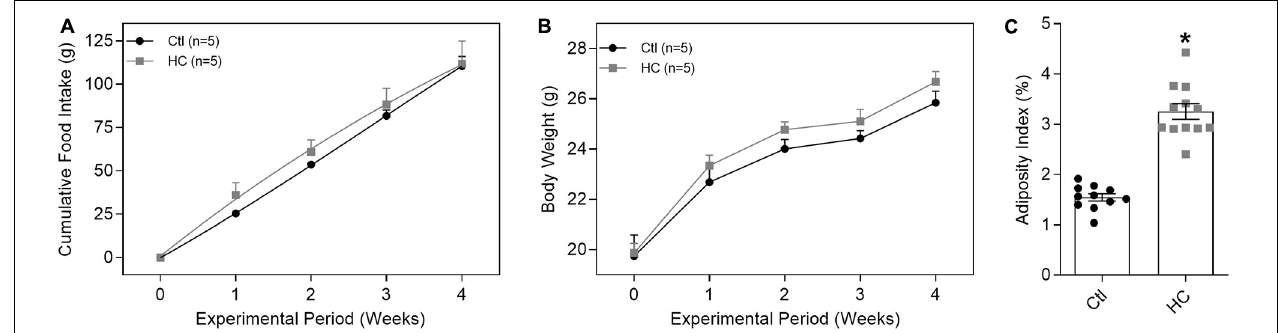
FIGURE 1 | Evaluation of (A) cumulative food intake, (B) body weight, and (C) adiposity index of mice fed standard or HC diets. Values represent mean ± SEM. The total number of animals required to carry out the experiments in each group ( n ) is presented in parentheses or in the dispersion points in the graphs. Statistical significance was determined using (A,B) two-way ANOVA followed by Holm–Sidak’s post hoc test or (C) Student’s t -test. * p < 0.05 vs.